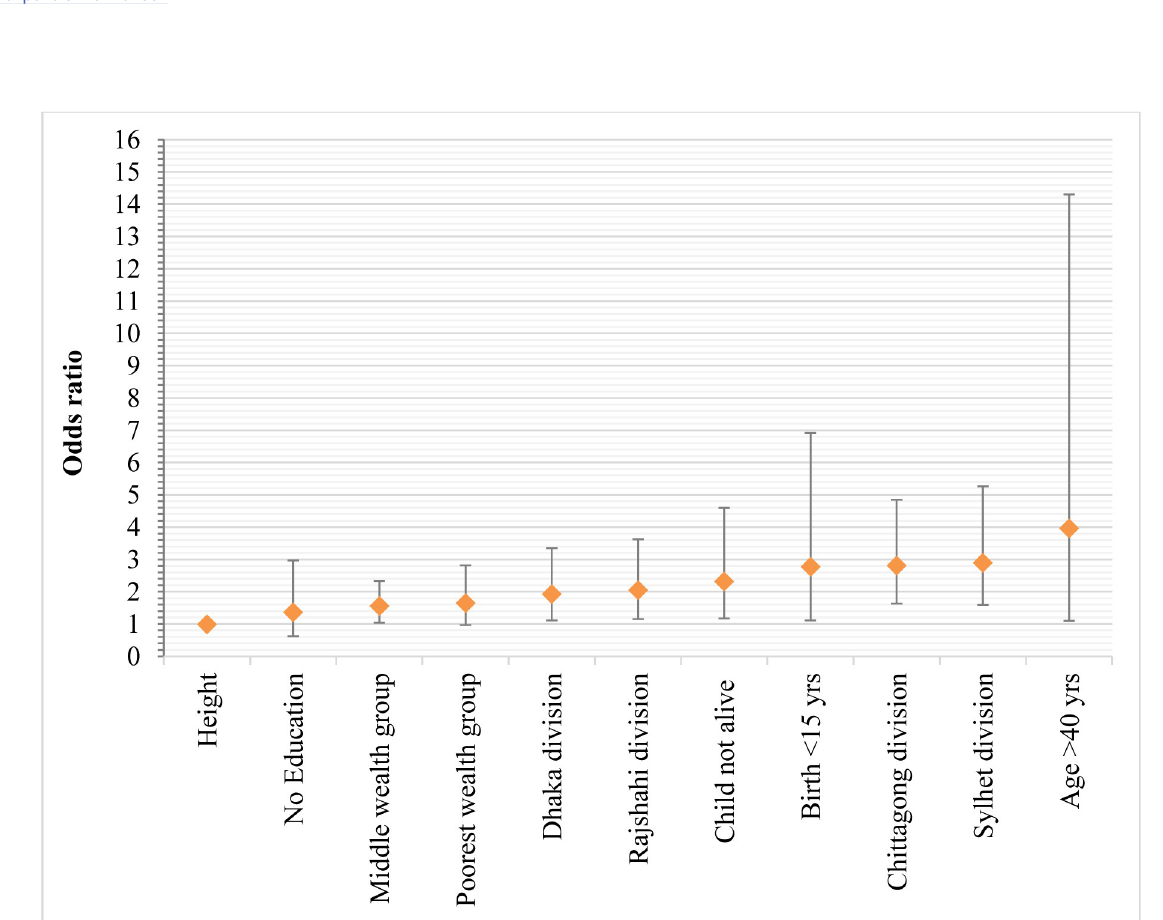
Fig 4. The odds ratio for significantly associated determinants of